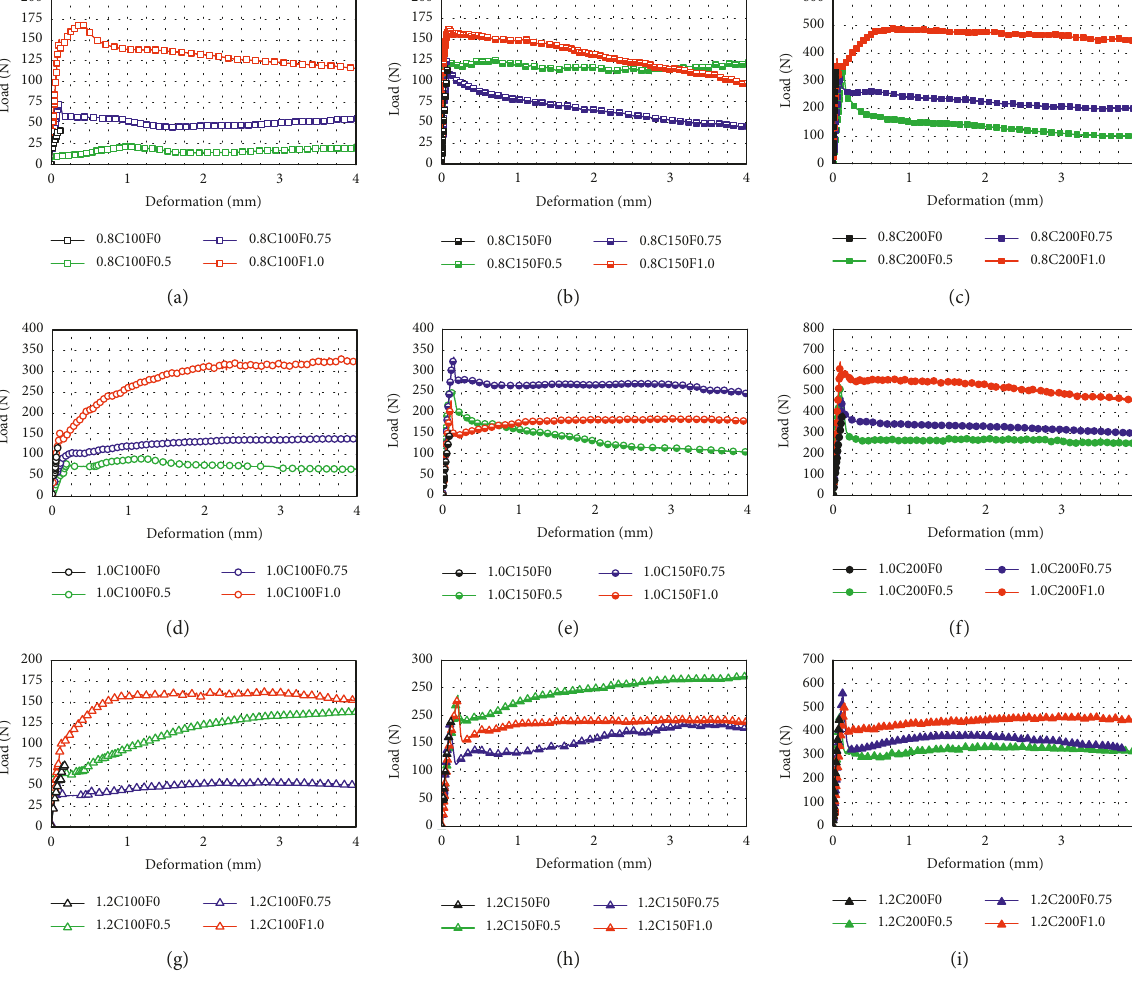
Figure 5: (a–i) Typical flexural curves of specimens with different fiber